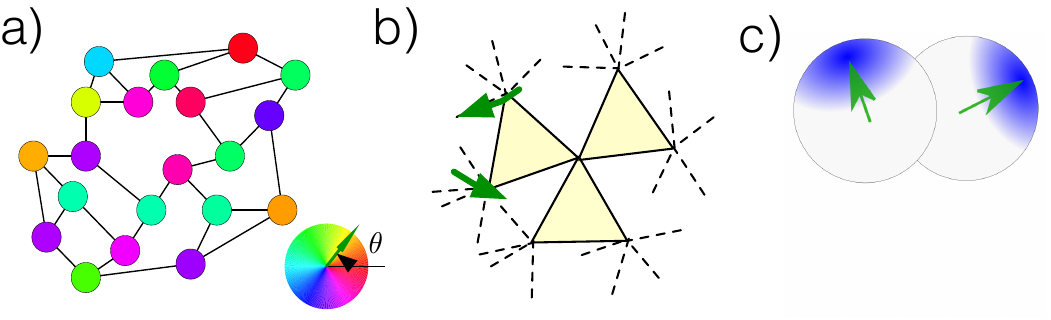
Figure 1: Glassy systems carrying ’spins’ representing rotational degree of freedoms. a) Continuous coloring of a graph : The color angle 0 < θ < 2 π , as in the standard HSV color map, can be represented by a XY spin, i.e. a vector with M = 2 compo- nent (green arrow). The example shown here is a solution to the requirement that color angle on adjacent vertexes must be greater than or equal to 2 π/ 3. b) Geomet- rically frustrated magnets : vectorial spins (green arrows) with anti-ferromagnetic couplings on adjacent vertexes on corner sharing triangles (e.g. kagome lattice), tetrahedra (e.g. pyrochlore lattice). The ground states are highly degenerate due to the loose connectivity of the lattices. c) Glass forming liquids of molecules or colloidal particles with ’spins’ : a simple molecule or a colloidal particle, like the Janus particle, is symmetric under rotation around an axis whose direction can be specified by a